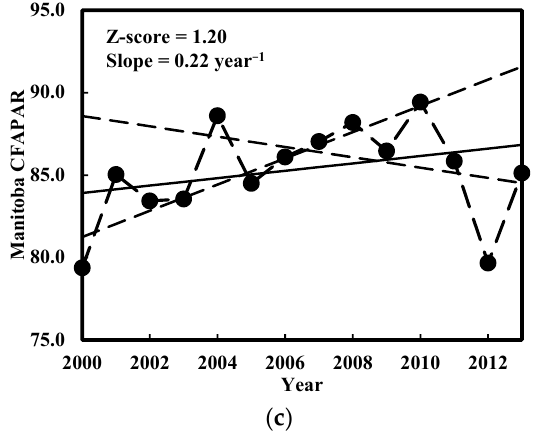
Figure 7. Temporal trends of annual CFPAR in Alberta (AB) ( a ); Saskatchewan (SK) ( b ); and Manitoba (MB) ( c ); respectively.